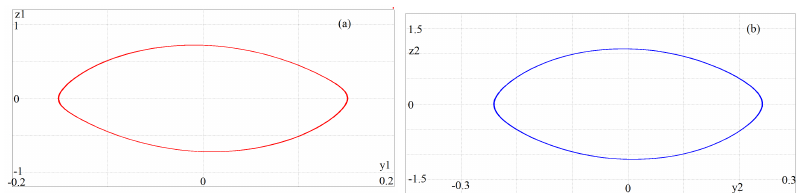
Figure 19. Phase-space diagrams of the circuit when f = 12.732 kHz. The corresponding value of ω nd is 4.00. ( a ) x -axis is the voltage of y 1 in V and y -axis is the voltage of z 1 in V, ( b ) x -axis is the voltage of y 2 in V and y -axis is the voltage of z 2 in V. The initial condition has been chosen at ( 0.333,0,0,0 ) to obtain the phase portraits. (Color Online).